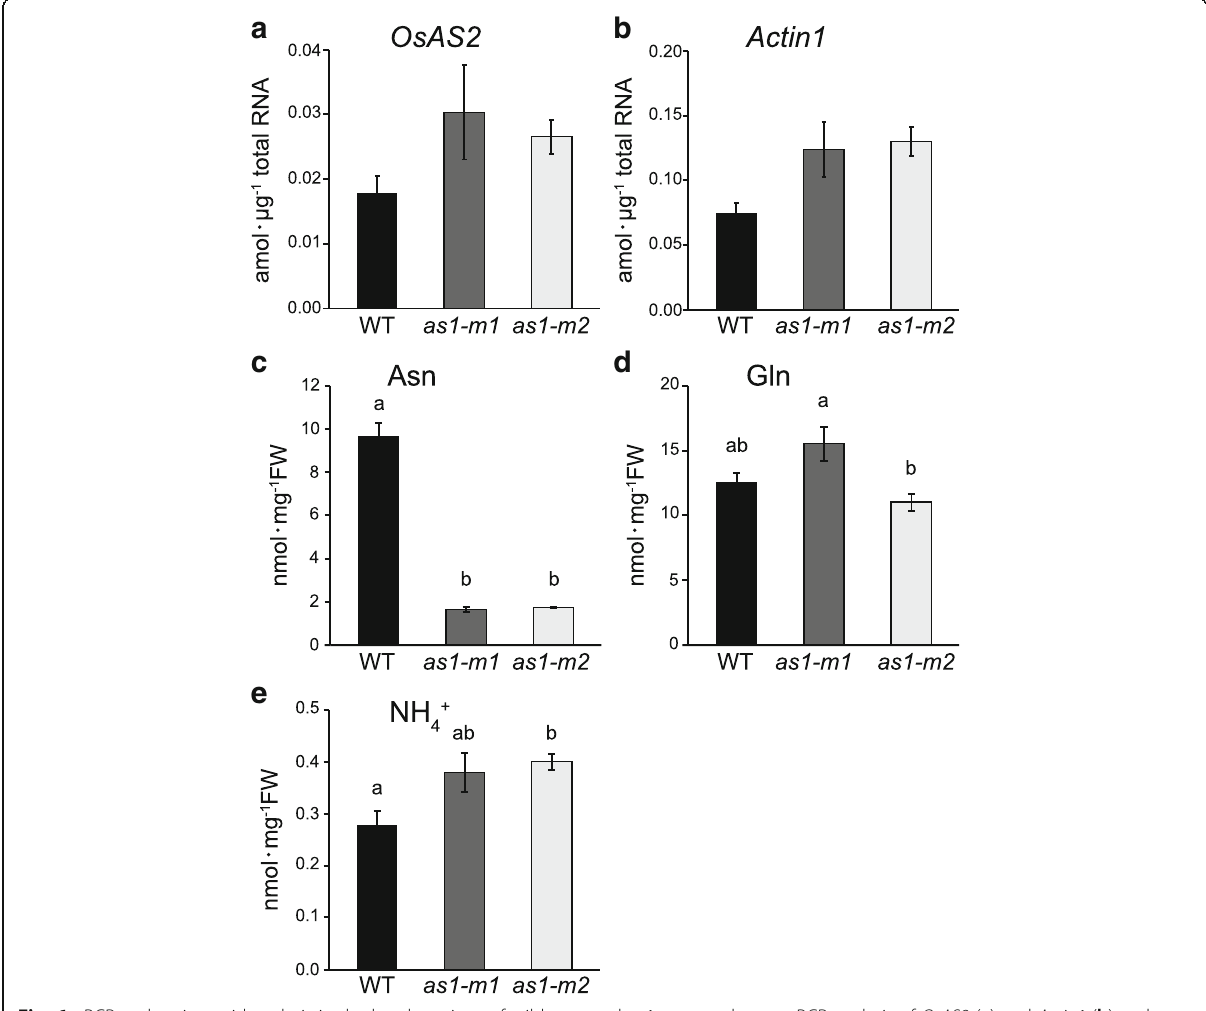
Fig. 6 qPCR and amino acid analysis in the basal portions of wild-type and as1 mutant shoots. qPCR analysis of OsAS2 ( a ) and Actin1 ( b ) and analyses of asparagine ( c ), glutamine ( d ) and NH 4+ contents ( e ) were performed in the basal portions of shoots of the wild type (WT: black column) and two lines of as1 mutants ( as1-m1 and as1-m2 : dark and light grey column, respectively). Seedlings were grown hydroponically in the presence of 1 mM NH 4 Cl until the fourth-leaf stage. Mean values with SE of four independent samples are shown. One-way ANOVAs followed by Bonferroni tests were used to identify significant differences between the wild type and as1 mutants ( P <